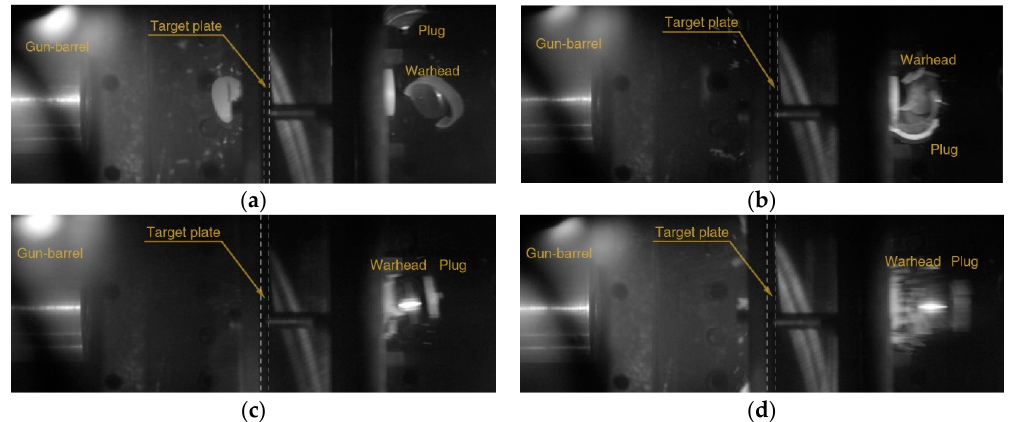
Figure 2. Initial and residual velocities with curve fit for ( a ) 5 and ( b ) 10 mm thick aluminum plates.